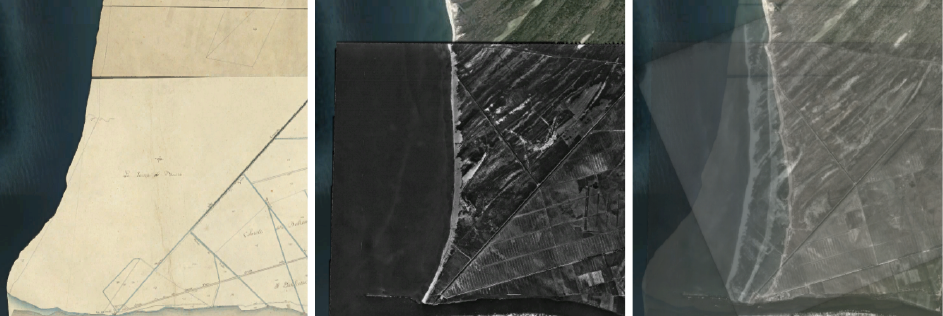
Figure 13. Snapshots of the mouth of the river Arno, near Pisa. Left : A cadastral map from 1765. Middle : Aerial photo from 1962. Right : An overlay of the cadastral map, the historical photos from 1943 and 1962 and the Google Earth modern satellite photo. The user can visually perceive in a single image the changes in the coastal line throughout two and a half centuries ( c (cid:13) MiBAC-ICCD, Aerofototeca Nazionale, fondo RAF. c (cid:13) 2010